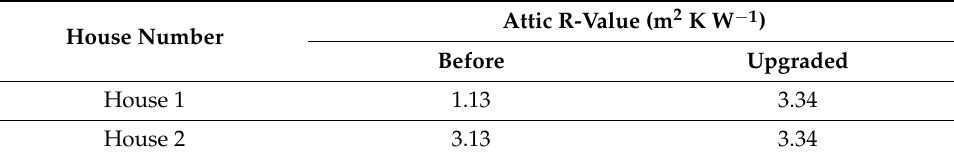
Table 3. Upgraded houses attic R-Value